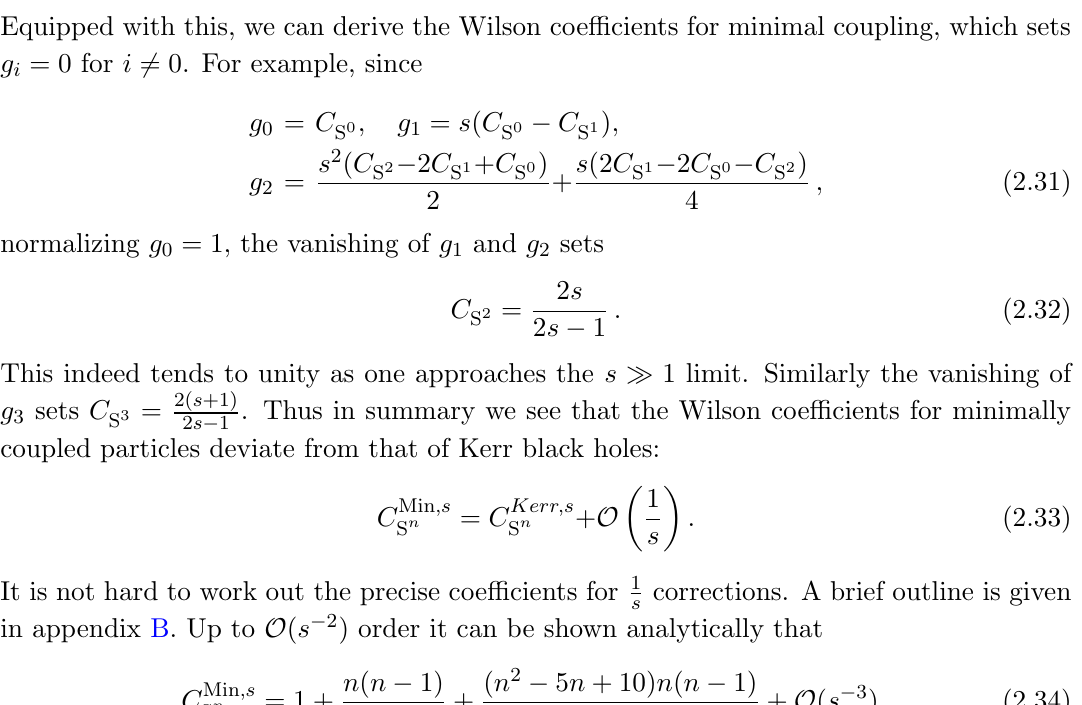
Figure 1 . The graviton exchange diagram between source a and b that yields the leading 1 singularity, which is responsible for the classical